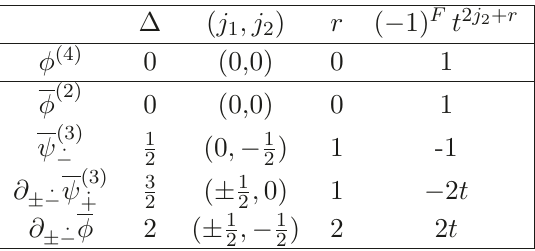
Table 3 . Contributions to the index of the [0 ′ ] multiplet. j 1 and j 2 (which can take positive and negative values) stand for third components of the two SU(2) spins which label the states in the superconformal index. Each undotted (dotted) For the [0 ′ ] multiplet in (3.9) the analysis goes as follows. One has to consider the fields X (“letters”) with δ